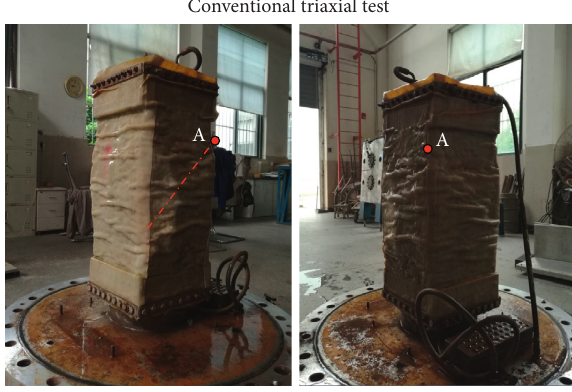
Figure 7: Typical failure state in true triaxial